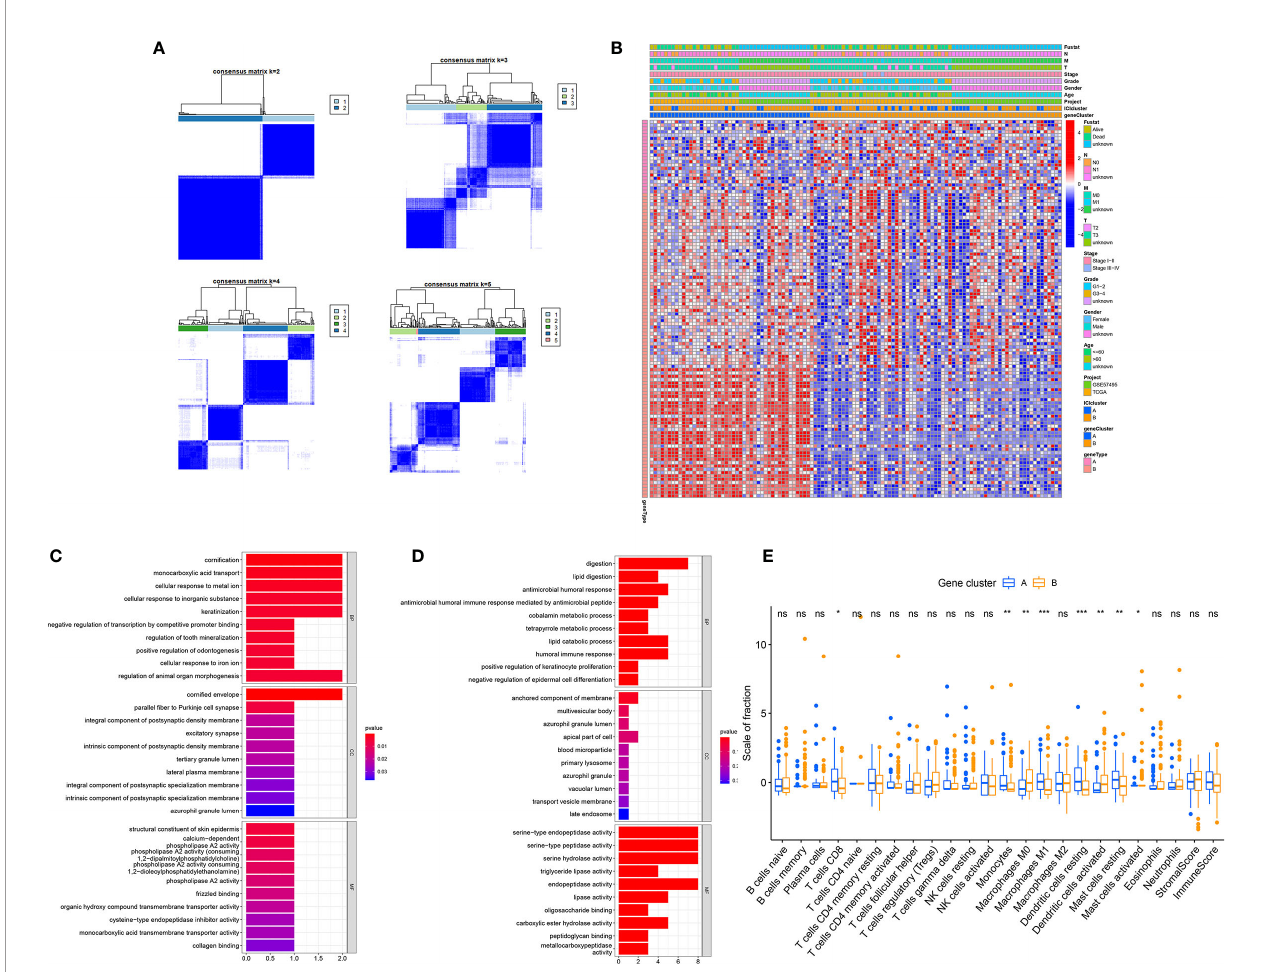
FIGURE 3 | Identi fi cation of Immunogenic Gene Subtypes. (A) Consensus matrixes of PC samples, representing each k (k=2 – 5). (B) Unsupervised clustering of common DEGs in both ICI cluster cohorts for patient strati fi cation: gene clusters A and B. (C, D) Gene Ontology (GO) enrichment analysis of two ICISGs: ICISG-A (C) and ICISG-B (D) . The x-axis represents gene quantity in each GO term. (E) The fraction of TIICs in both gene clusters. Plots of the immune and stromal score of both gene clusters. Signi fi cance was computed using the Wilcoxon test, * P < 0.05; ** P < 0.01; *** P < 0.001. ns, not signi fi